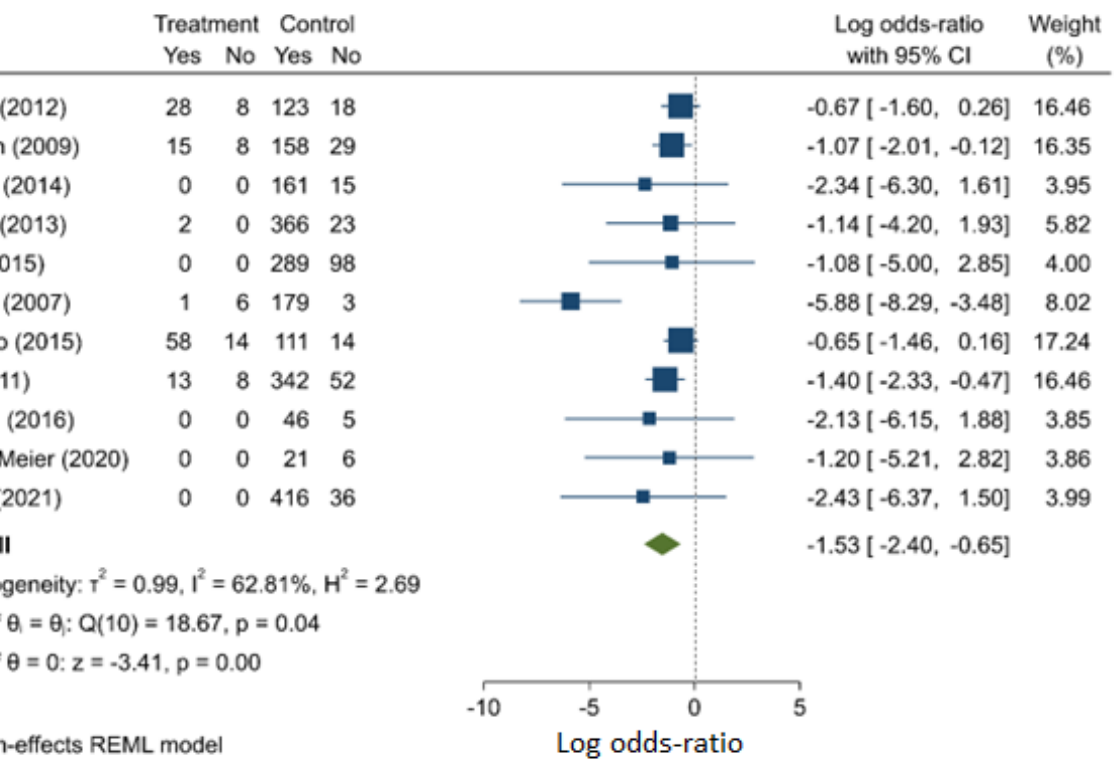
Figure 8. Surgery compared with medical therapy as risk factor for mortality.